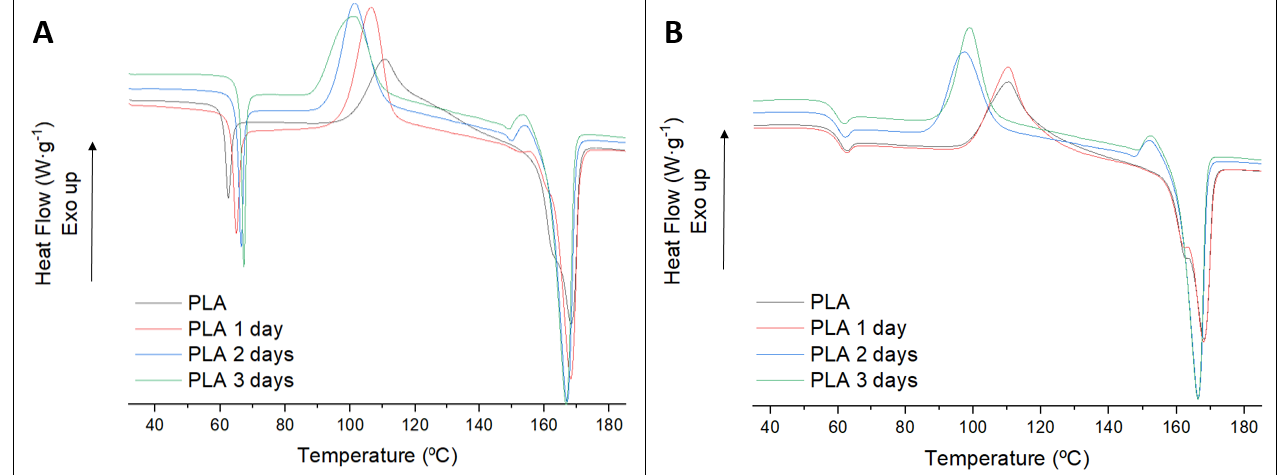
Figure 5. First ( A ) and second ( B ) heating of PLA samples from the degradation test.